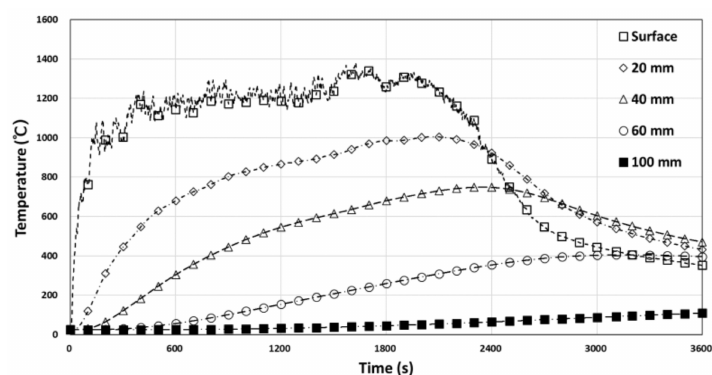
Figure 7. Temperature distribution by depth based on vehicle fire